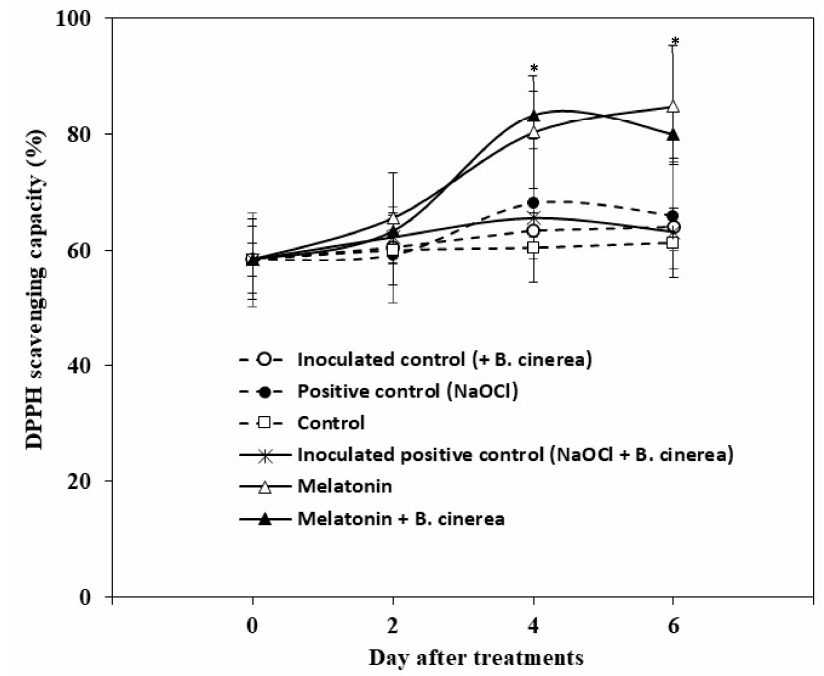
Figure 5. DPPH scavenging capacity of the strawberries treated with exogenous melatonin and inoculated with and without Botrytis cinerea during storage at room temperature (25 ± 2 ◦ C, 80–85% RH) for 6 days. Data are the means ± S.D. of three replications (three sets of ten fruits). Significant differences between treatments are indicated with asterisks (* ( p < 0.05)).